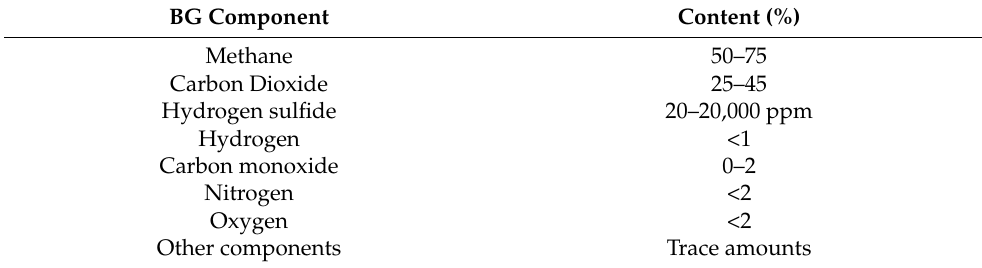
Table 1. Biogas (BG) composition [6].